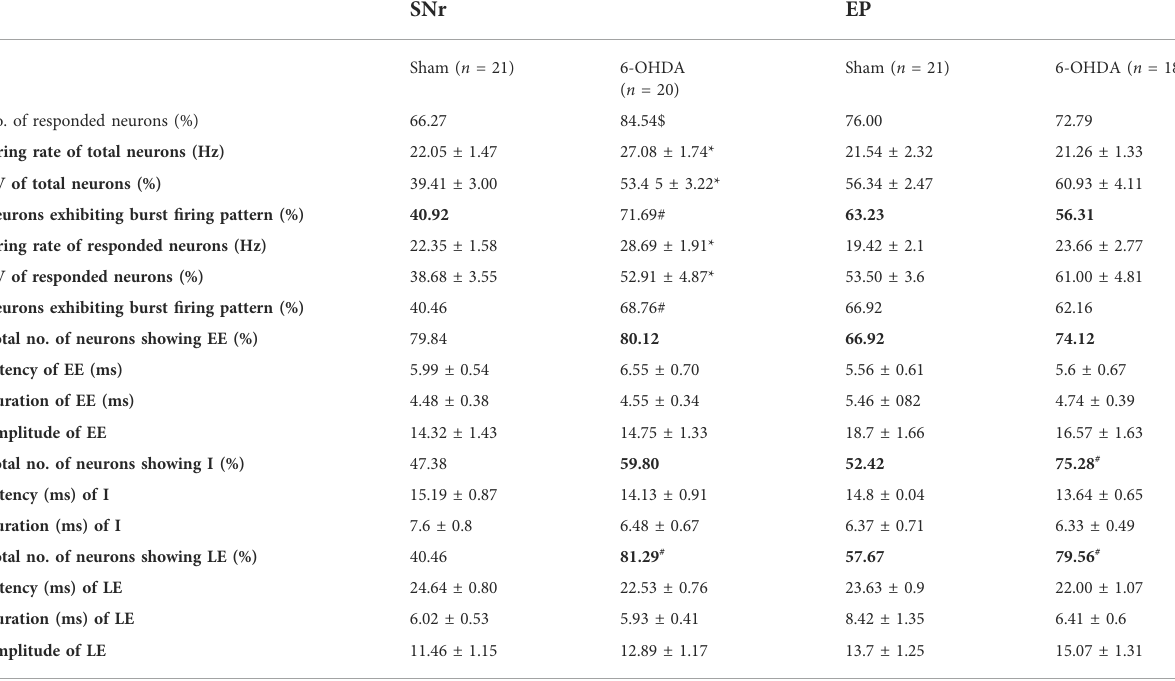
TABLE 1 Electrophysiological characteristics of the spontaneous and cortical-evoked responses in neurons from the sensorimotor circuit of substantia nigra pars reticulata and entopeduncular nucleus in sham and 6-OHDA-lesioned